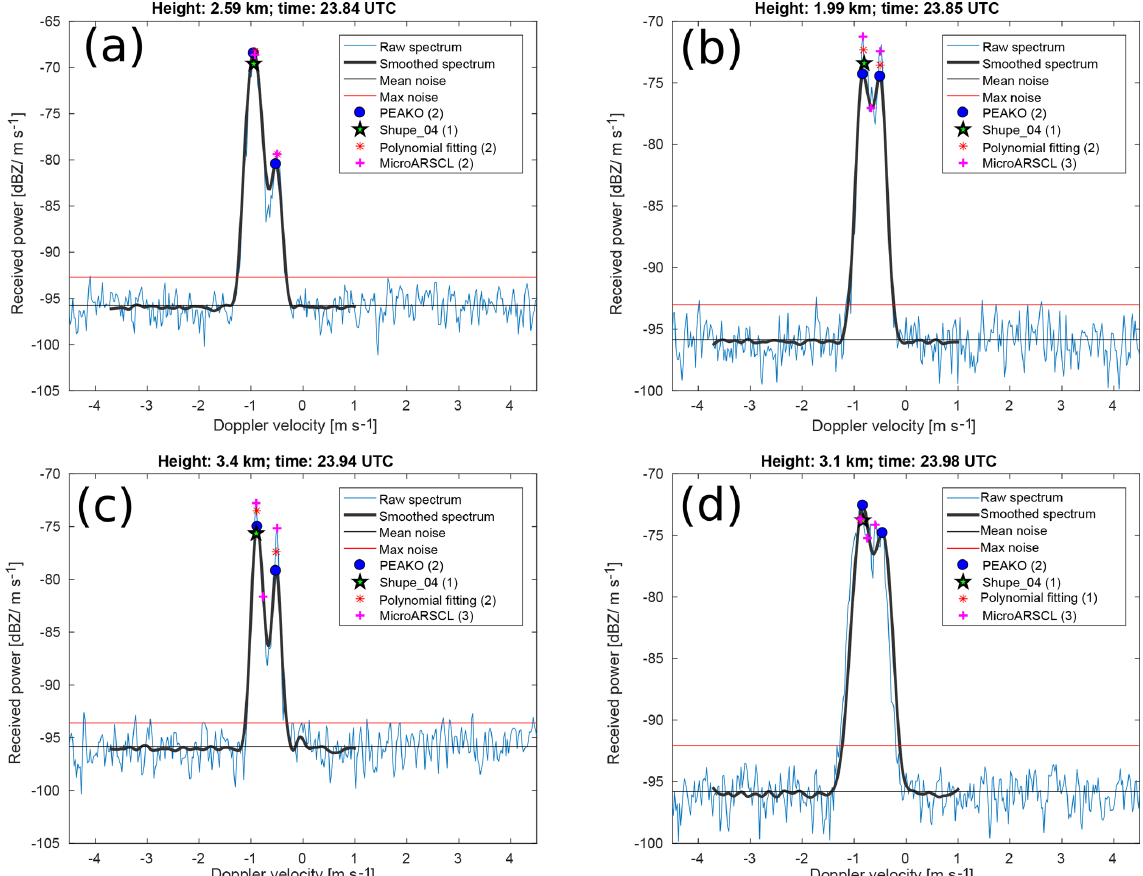
Figure C4. Four example spectra picked from the case study on 7 February 2014, 23.75–24UTC. Please note that the y axis scale is different for each of the spectrum